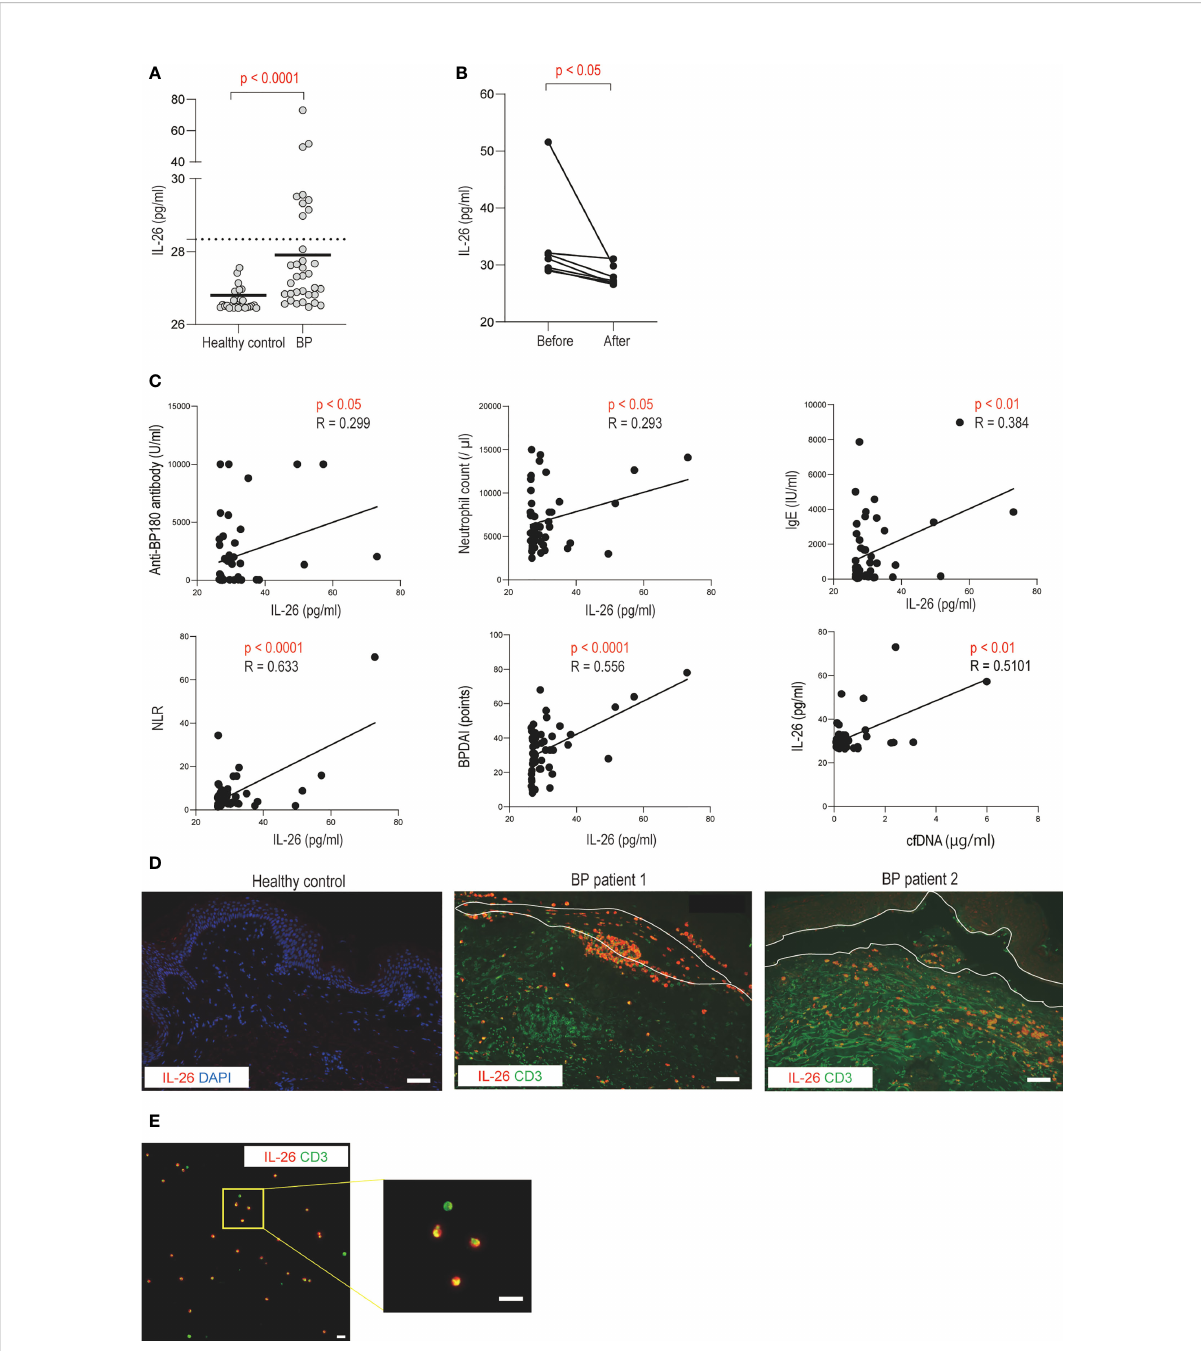
FIGURE 3 Increased serum IL-26 levels and in fi ltration of IL-26-producing CD3-positive T cells in BP patients (A) Serum IL-26 levels in BP patients (n = 39), and healthy controls (n = 33) were determined by a speci fi c enzyme-linked immunosorbent assay. The horizontal lines indicate the median values. The broken lines show the cut-off value (mean + 2 SD of healthy controls). (B) Changes in serum IL-26 levels before and after systemic treatment. (C) Correlations between serum IL-26 levels and disease activity markers, BPDAI, or cell-free DNA levels in BP patients. The solid lines indicate a linear regression line. (D) Immuno fl uorescence images for IL-26 in skin sections from healthy controls and BP patients. IL-26 (red) was co-stained with CD3 (green) and DAPI (blue). Results are representative of 2 out of 8 BP patients. Scale bar, 50 m m. (E) Immuno fl uorescence images for IL-26 in a blister fl uid smear from BP patients. IL-26 (red) was co-stained with CD3 (green) and DAPI (blue). Higher magni fi cation images are shown on the right side. Results are representative of three BP patients. Scale bar, 20 m